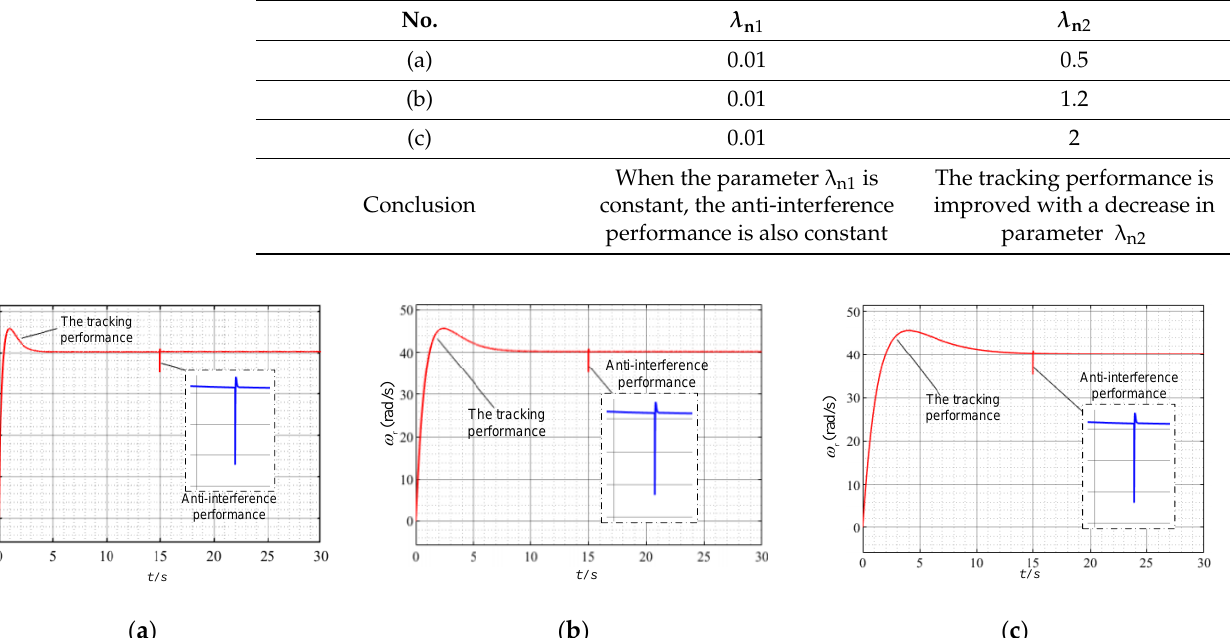
Figure 14. The output speed response curve of the system: ( a ) scheme (a); ( b ) scheme (b); ( c ) scheme (c).